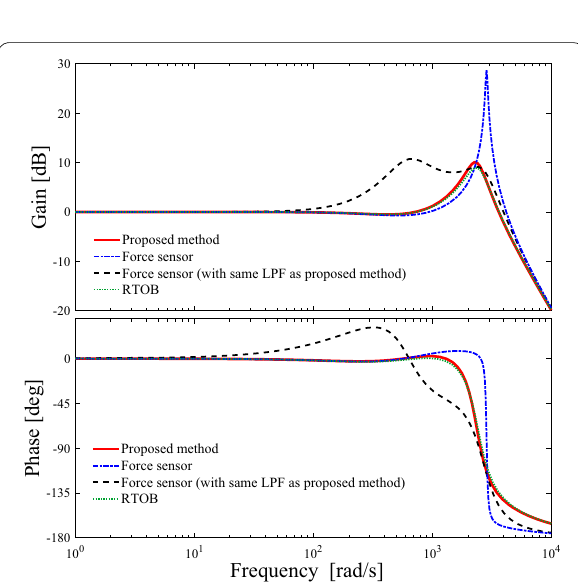
Fig. 6 Bode diagram of the transfer functions from command torque to output external